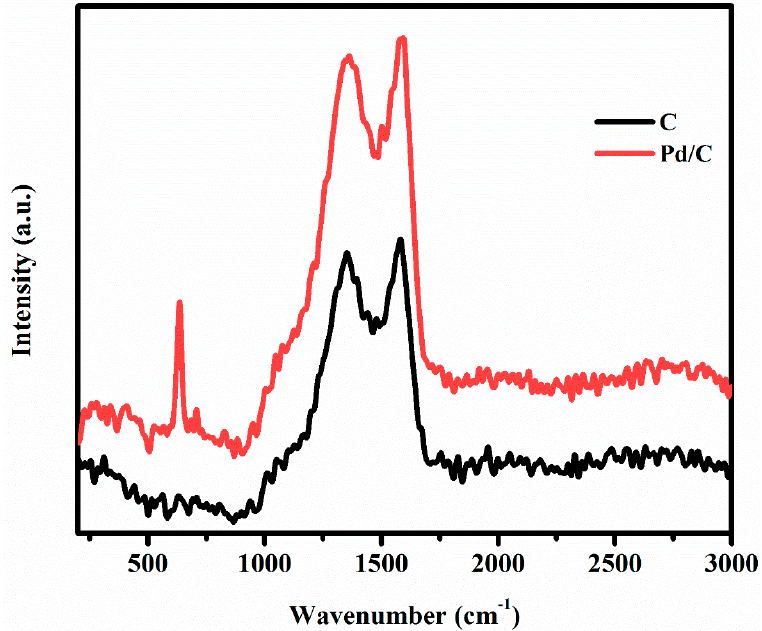
Figure 4. Raman spectra of CNFs and Pd / CNFs.